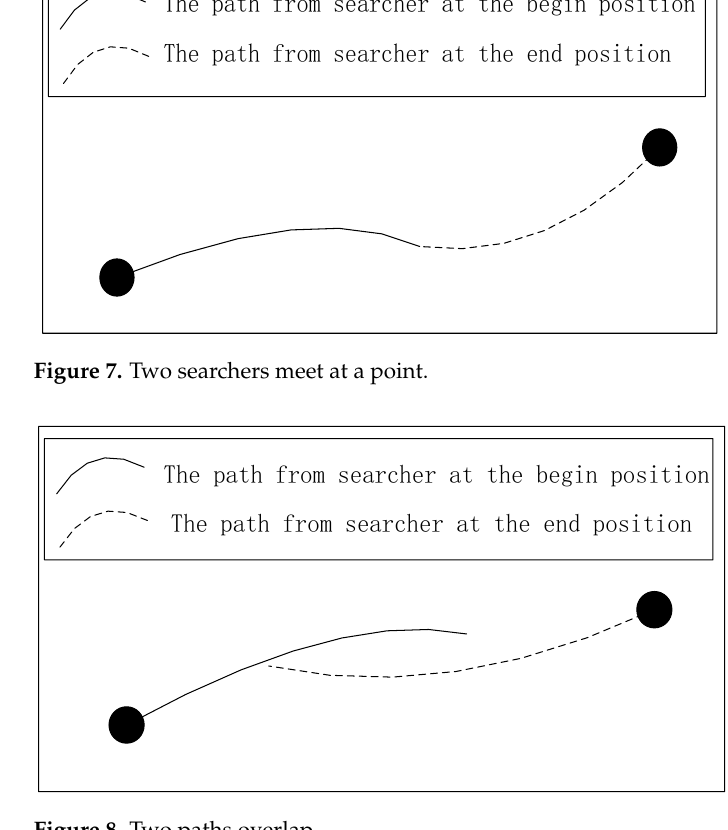
Figure 6. Two paths do not overlap. The path from searcher at the begin position The path from searcher at the end position